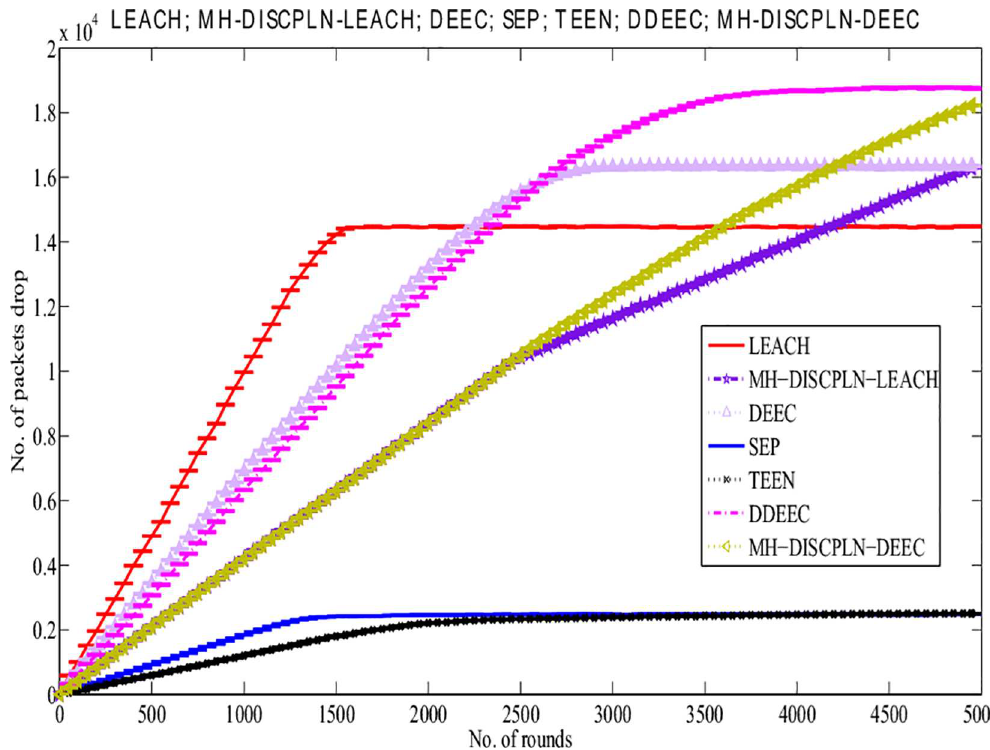
Fig 13. Performance comparison basedon packet drop for